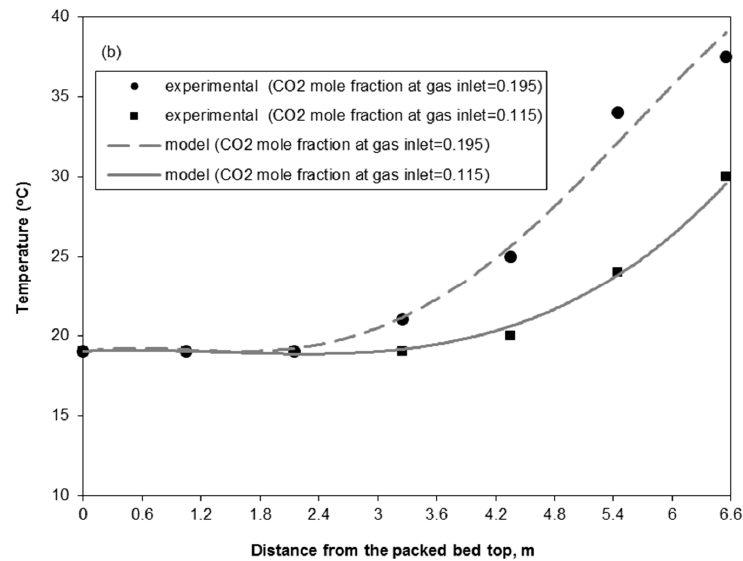
Figure 3. Experimental and theoretical axial CO 2 mole fraction ( a ) and temperature ( b ) profiles for CO 2 -MEA absorption in a countercurrent packed-bed column (D = 0.1 m; H = 6.55 m; CO 2 -2mol / L MEA system; Liquid flow rate = 13.5 m 3 / m 2 h; Gas flow rate = 14.8 mol / m 2 s; T in = 19 ◦ C). Experimental data were taken from Tontiwachwuthikul et al. [49].